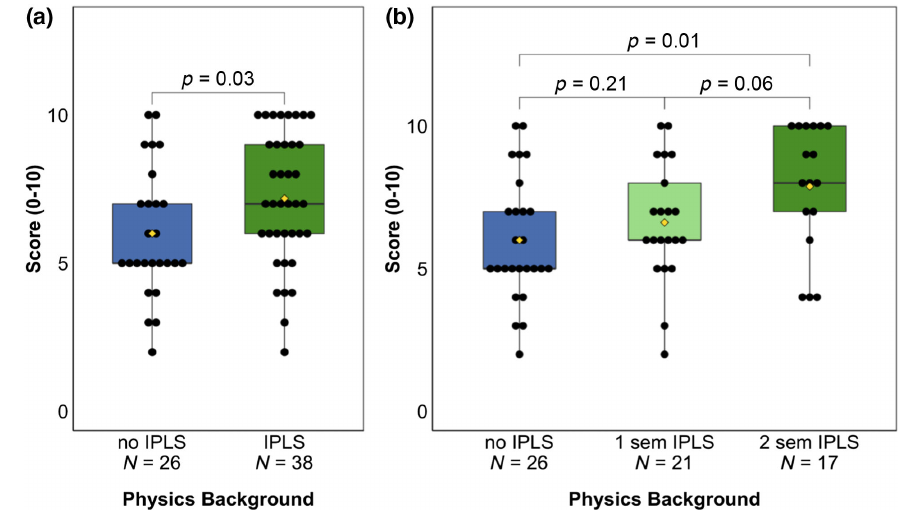
FIG. 3. Scores on the general quantitative skill elements of the code. (a) Students who took IPLS 1 (green box plot) scored significantly higher on the general quantitative skill elements of the code than those who did not take IPLS (blue box plot). (b) Scores on the general quantitative skill elements of the code for those who had taken no IPLS course, those who had taken one IPLS course, and those who had taken both IPLS courses. Only those who had taken both IPLS courses scored significantly higher on these code elements than those who had taken no IPLS. All p values are from Wilcoxon